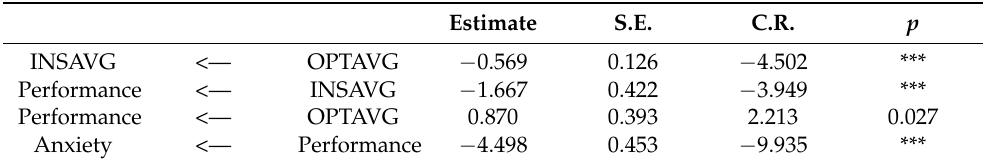
Table 4. Relationships between optimism, insecurity, anxiety, and performance. Sign (***) indicates the statistical significant relationships.